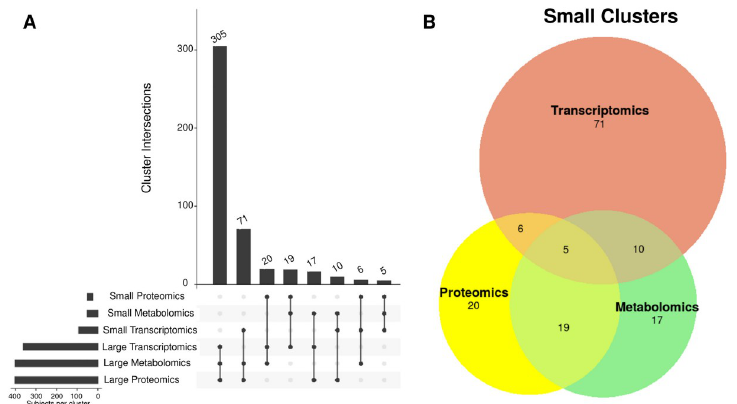
Fig 4. Summary of post-clustering -omics integration. A) Upset plot representing the intersecting clusterings from the single-omic analysis among subjects with all 3 -omic profiles. B) A Venn diagram of the smaller clusters for comparison among subjects specifically categorized in the smaller cluster in only 1 of the 3 -omic